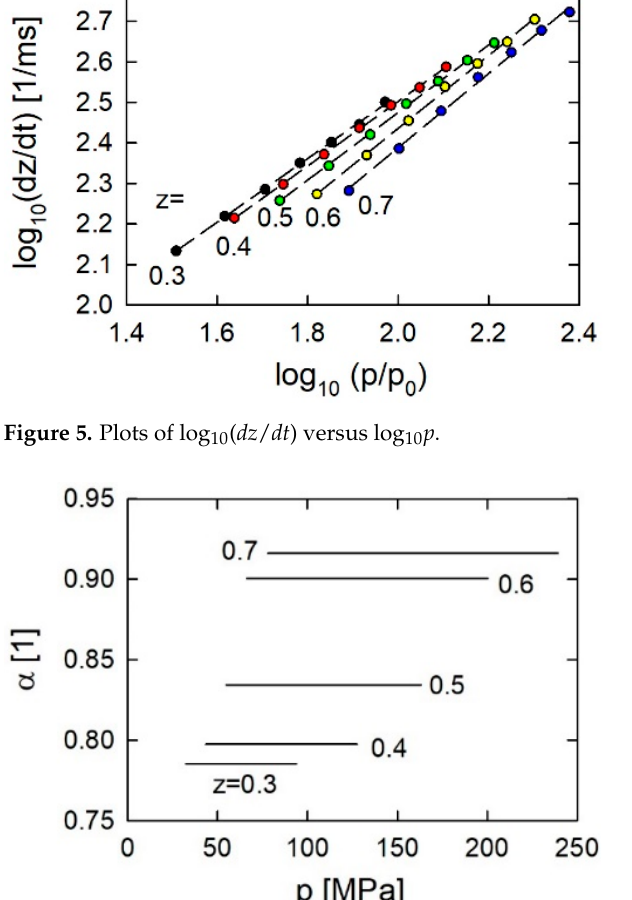
Figure 7. Plots of G ( z ) functions.